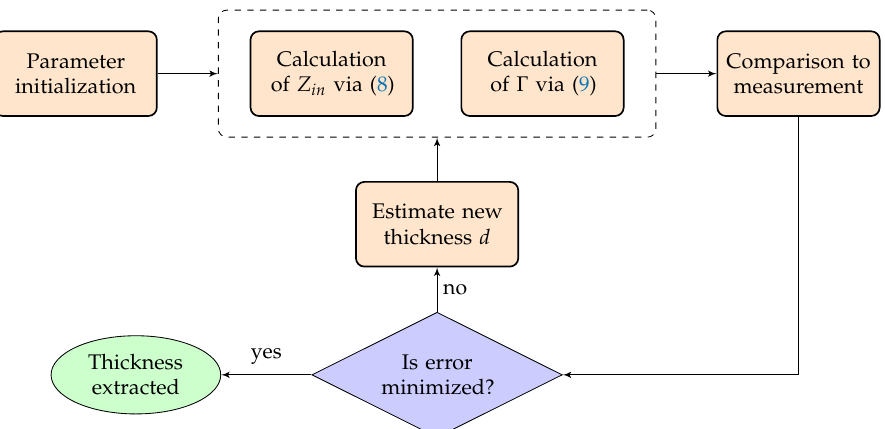
Figure 3. Flow chart describing the extraction of the thin film thickness, utilizing the proposed transmission line scheme.